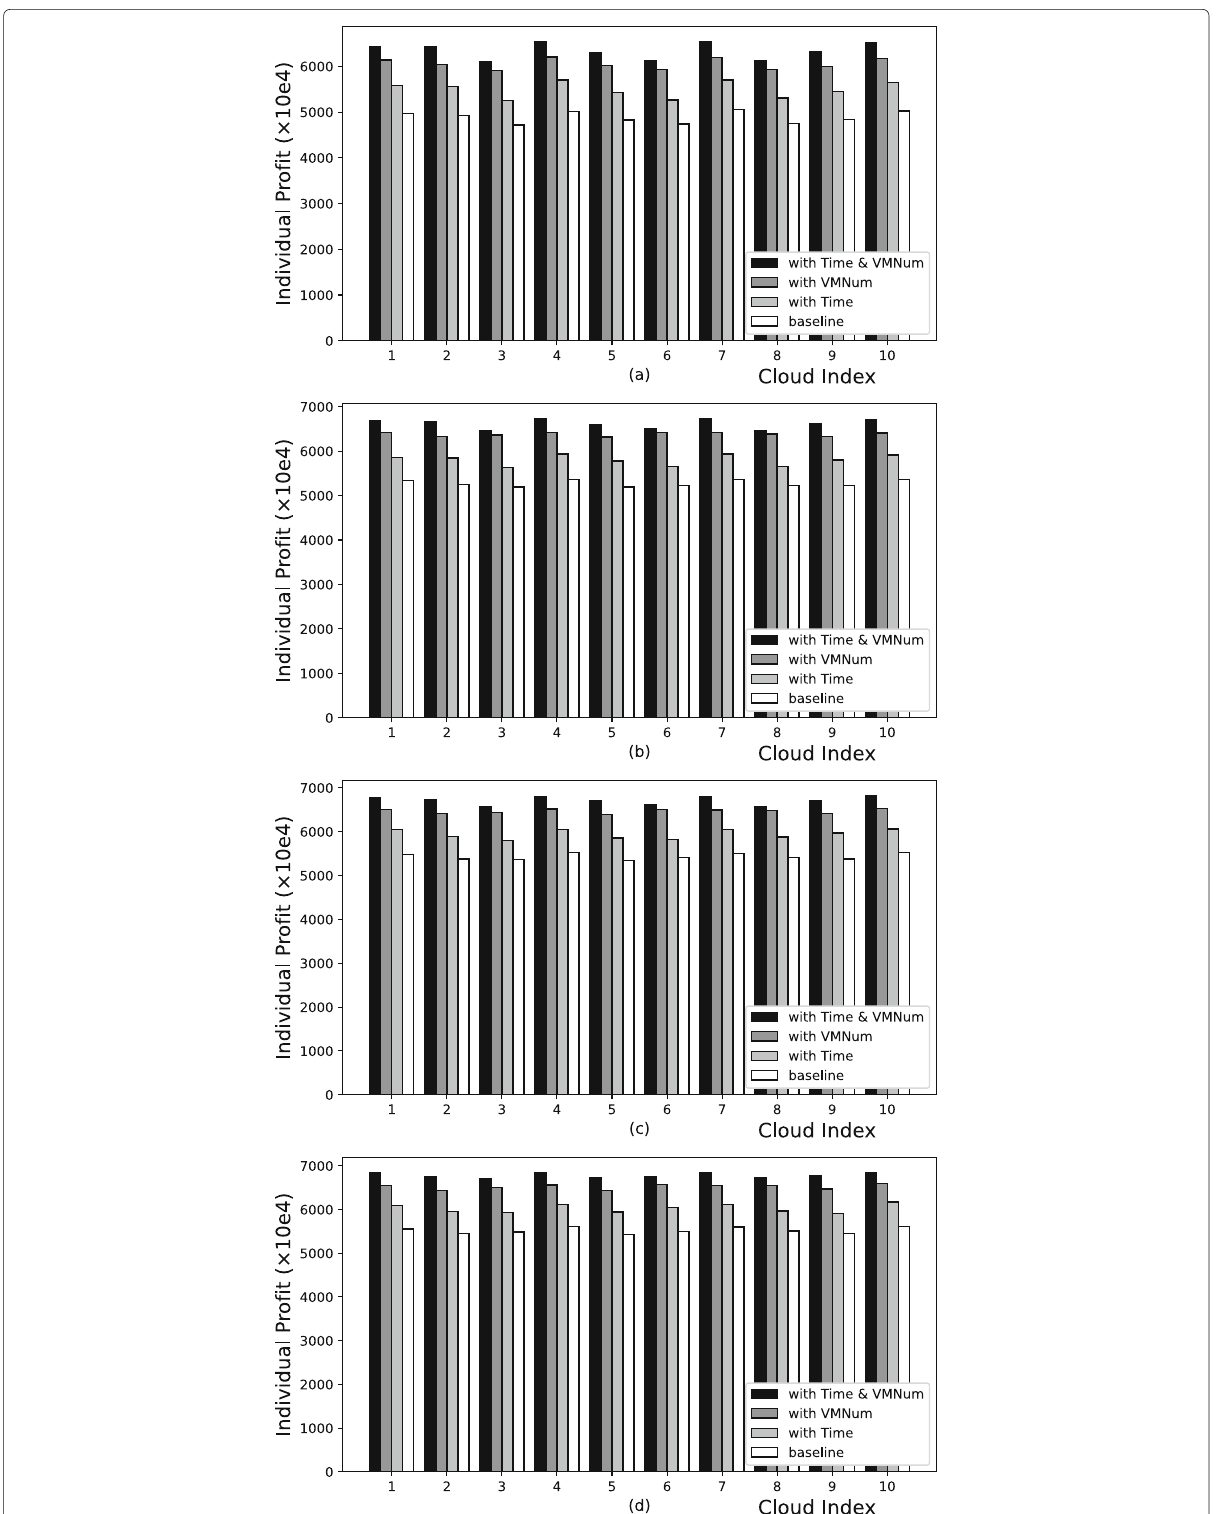
Fig. 5 Comparison of individual profits with different values of V . (a) V = 0.5 × 10 5 , (b) V = 2 × 10 5 , (c) V = 3.5 × 10 5 , (d) V = 5 × 10